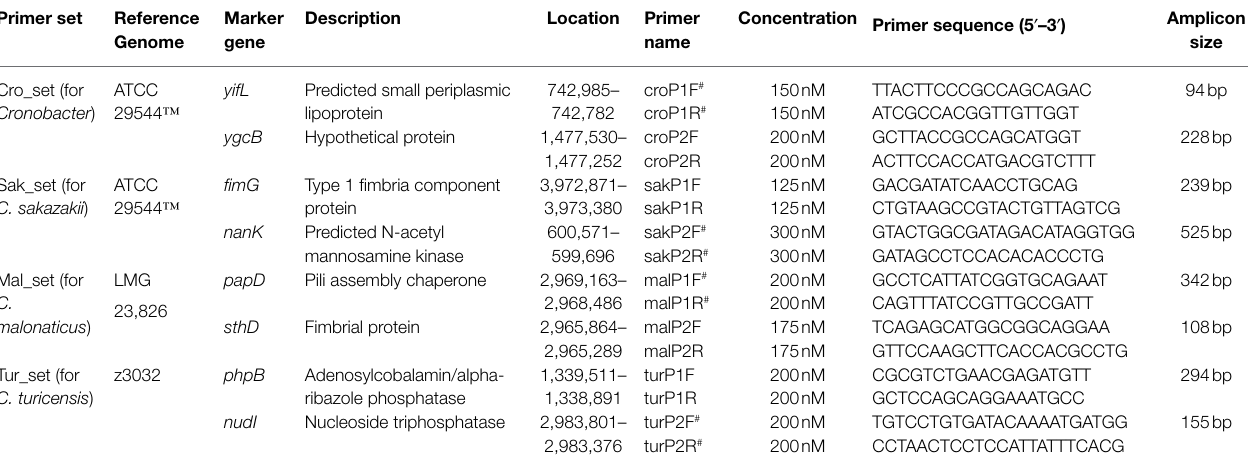
TABLE 1 | Primer sets utilized in PCR assay and their target